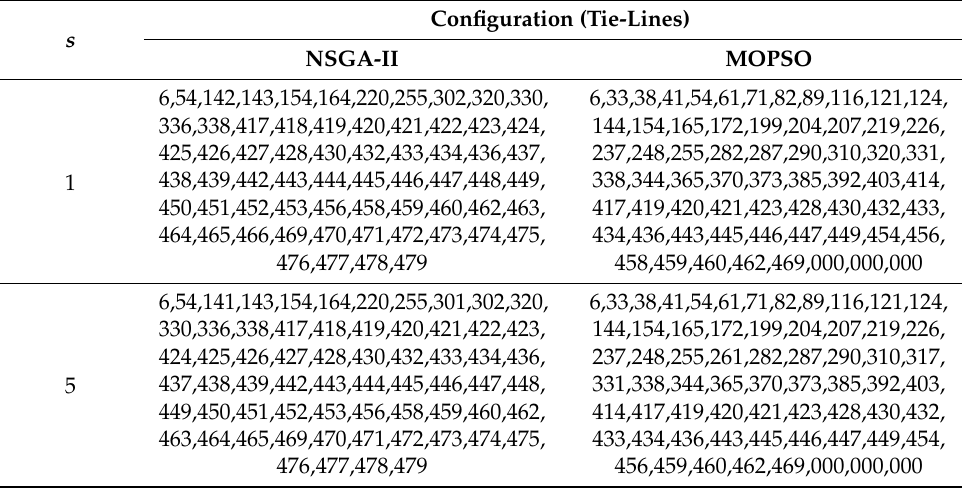
Table 12. The 415-node distribution network configurations at multiple